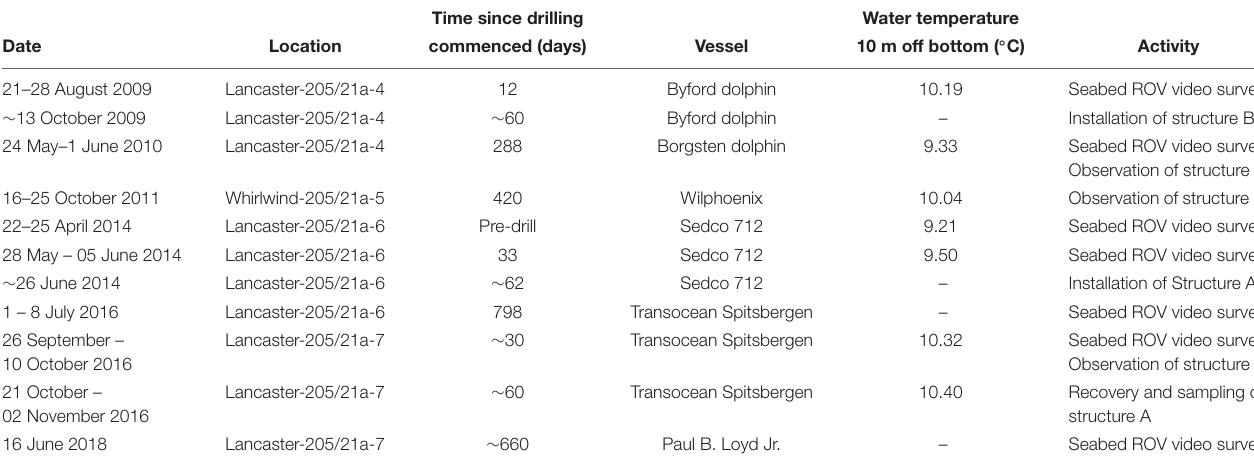
TABLE 2 | Time-line of key events relevant to this